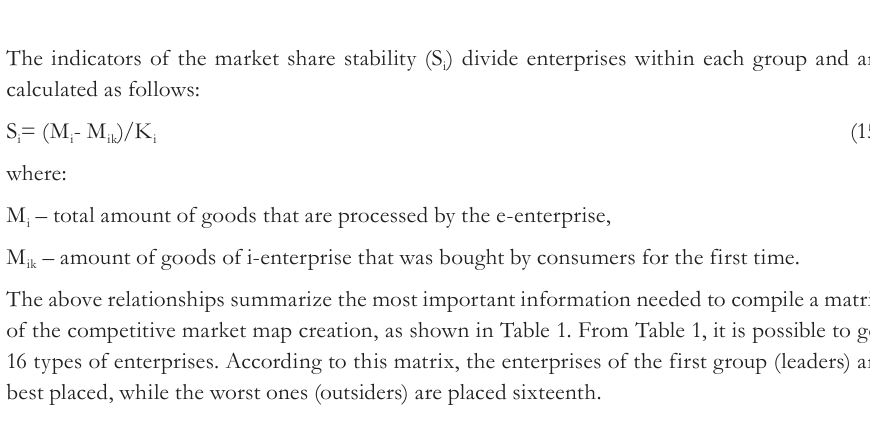
Tab. 1 – Matrix compilation of the competitive market map. Source: own